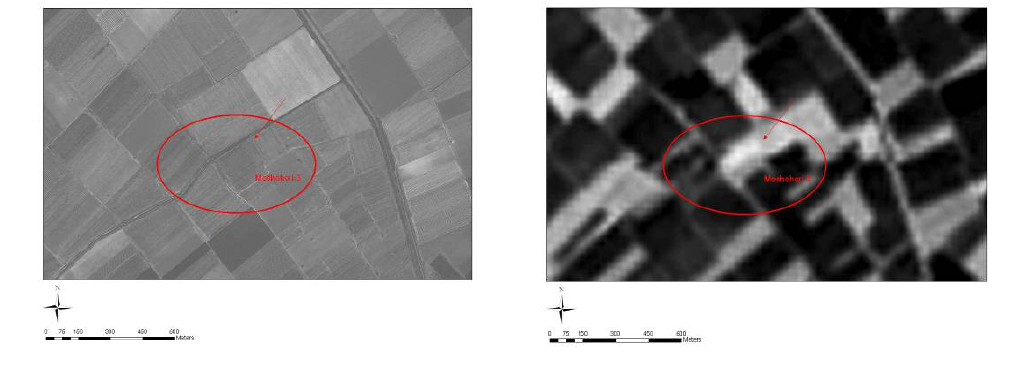
Figure 9. Settlement Moshohori represented in an IKONOS image (left) and the same region after image fusion between IKONOS and HYPERION (right).